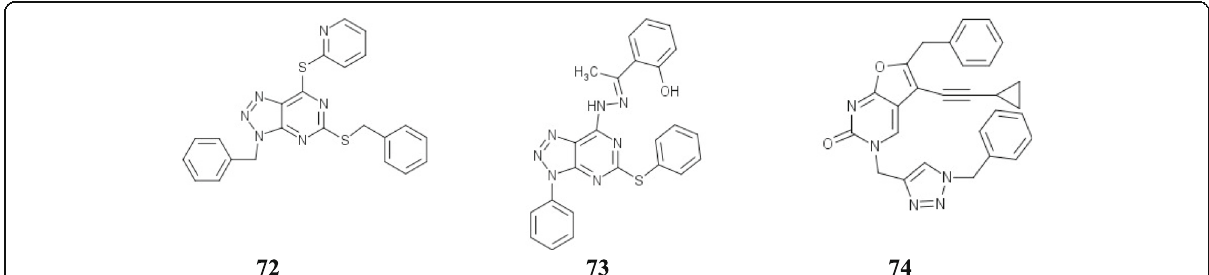
Fig. 24 Chemical structure of Triazolo and other triazolo pyrimidine